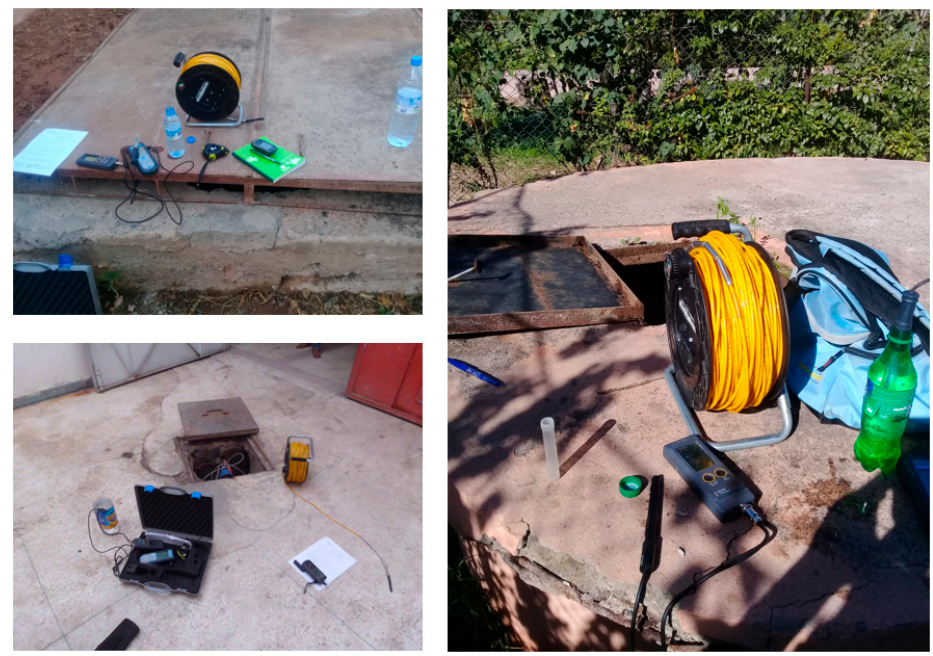
Figure 6 . Example of wells prospected and equipment used for groundwater level survey . Figure 6. Example of wells prospected and equipment used for groundwater level